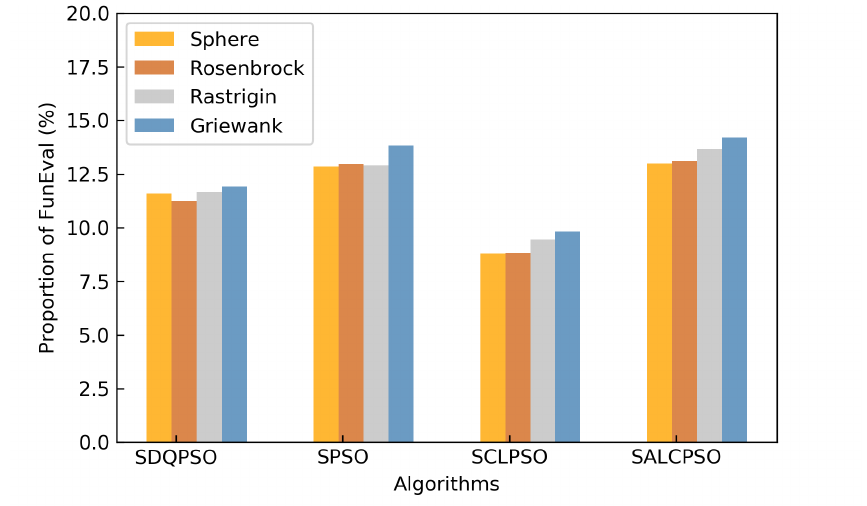
Figure 6. The fun evaluation proportion on Sphere, Rosenbrock, Rastrigin, and